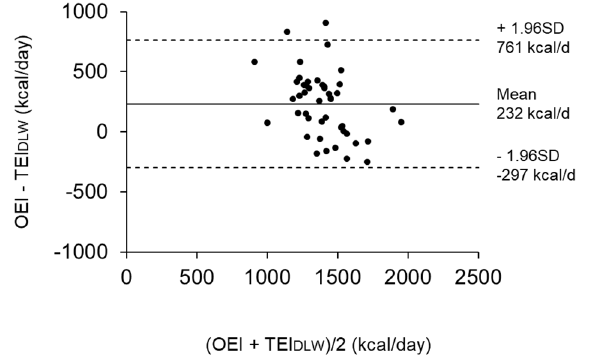
Table 1. Baseline characteristics and energy variables (analysis 1).